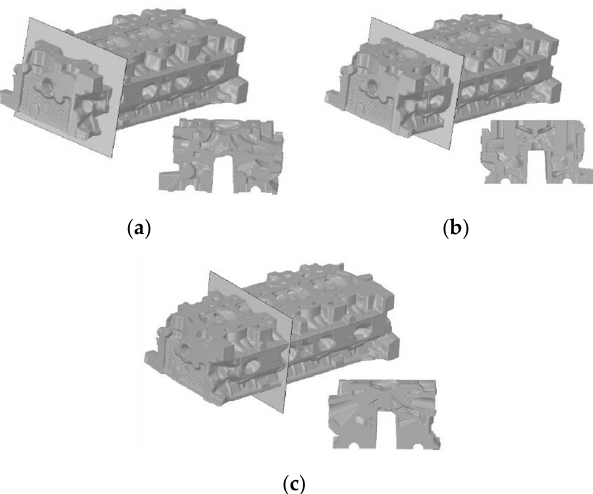
Figure 3. Surfaces for measurement of hardness of cylinder head casting: ( a ) cross-section 1 (55 mm from the face side), ( b ) cross-section 2 (115 mm from the face side), ( c ) cross-section 3 (160 mm from the face side).